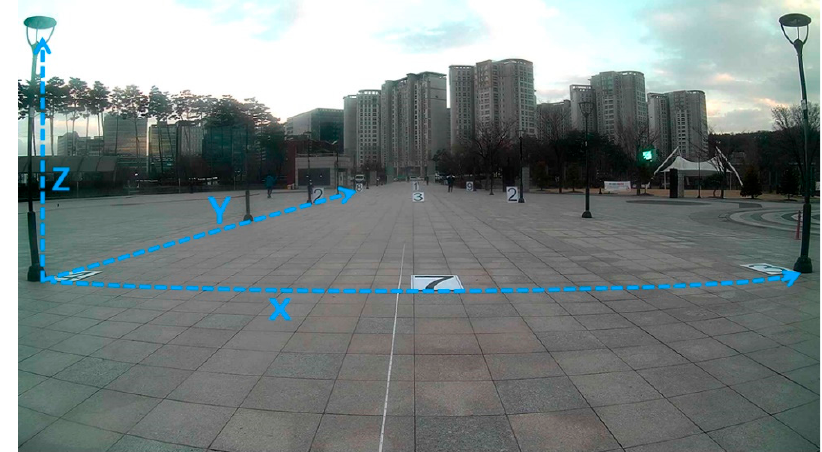
Figure 7. Floor plan using the world coordinate system.